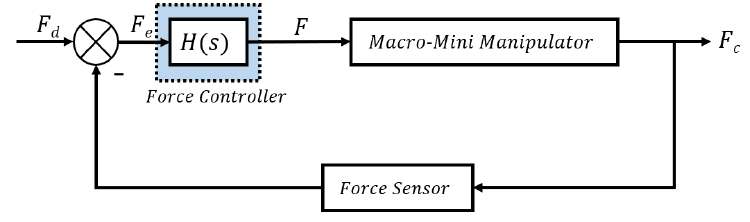
Figure 3. Block diagram of direct force